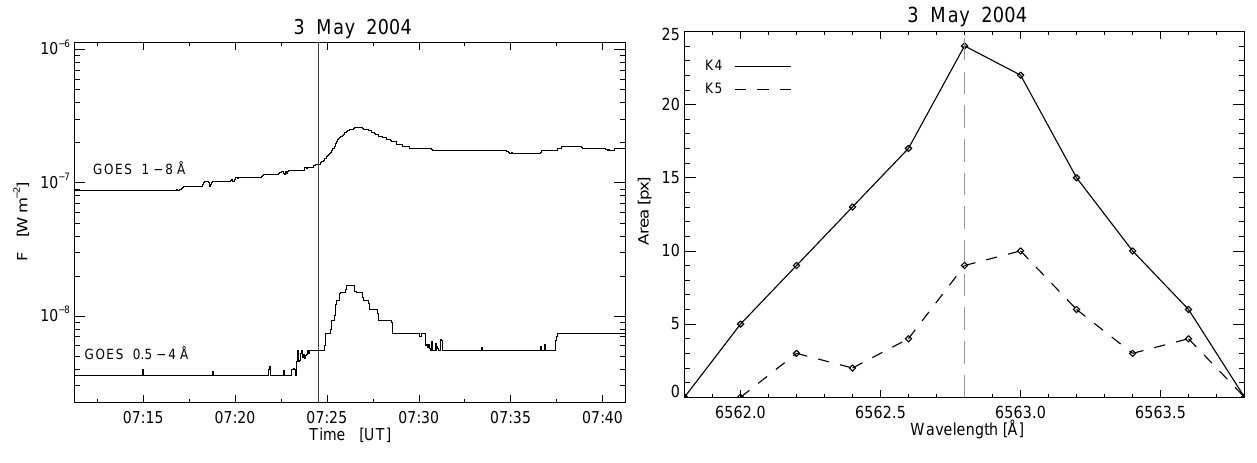
Fig. 4. Areas of the K4 and K5 flaring kernels of the B2.5 class solar flare at 07:24:33UT on 3 May 2004. The left and right panels are the same as on Fig.